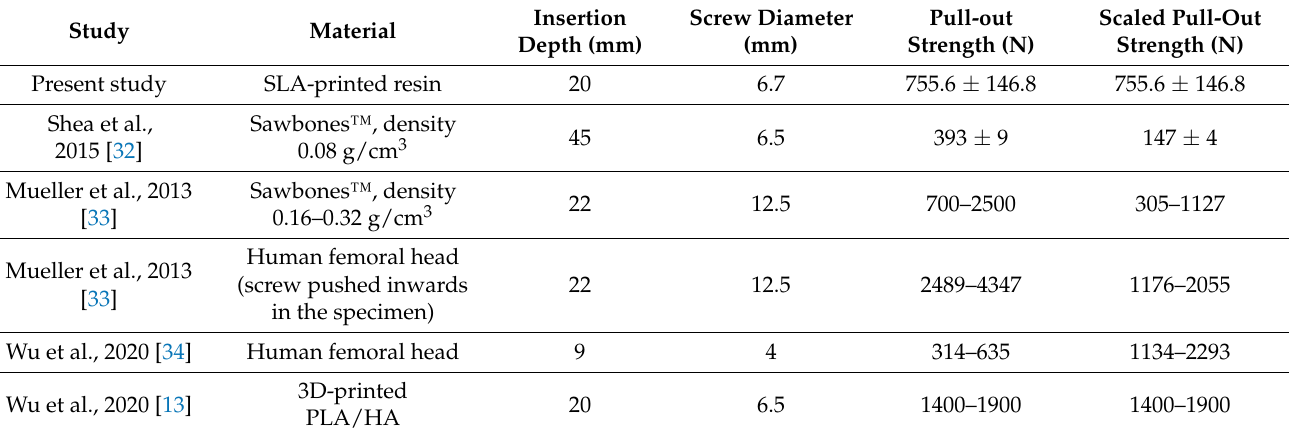
Table 6. Comparison of pull-out results from the